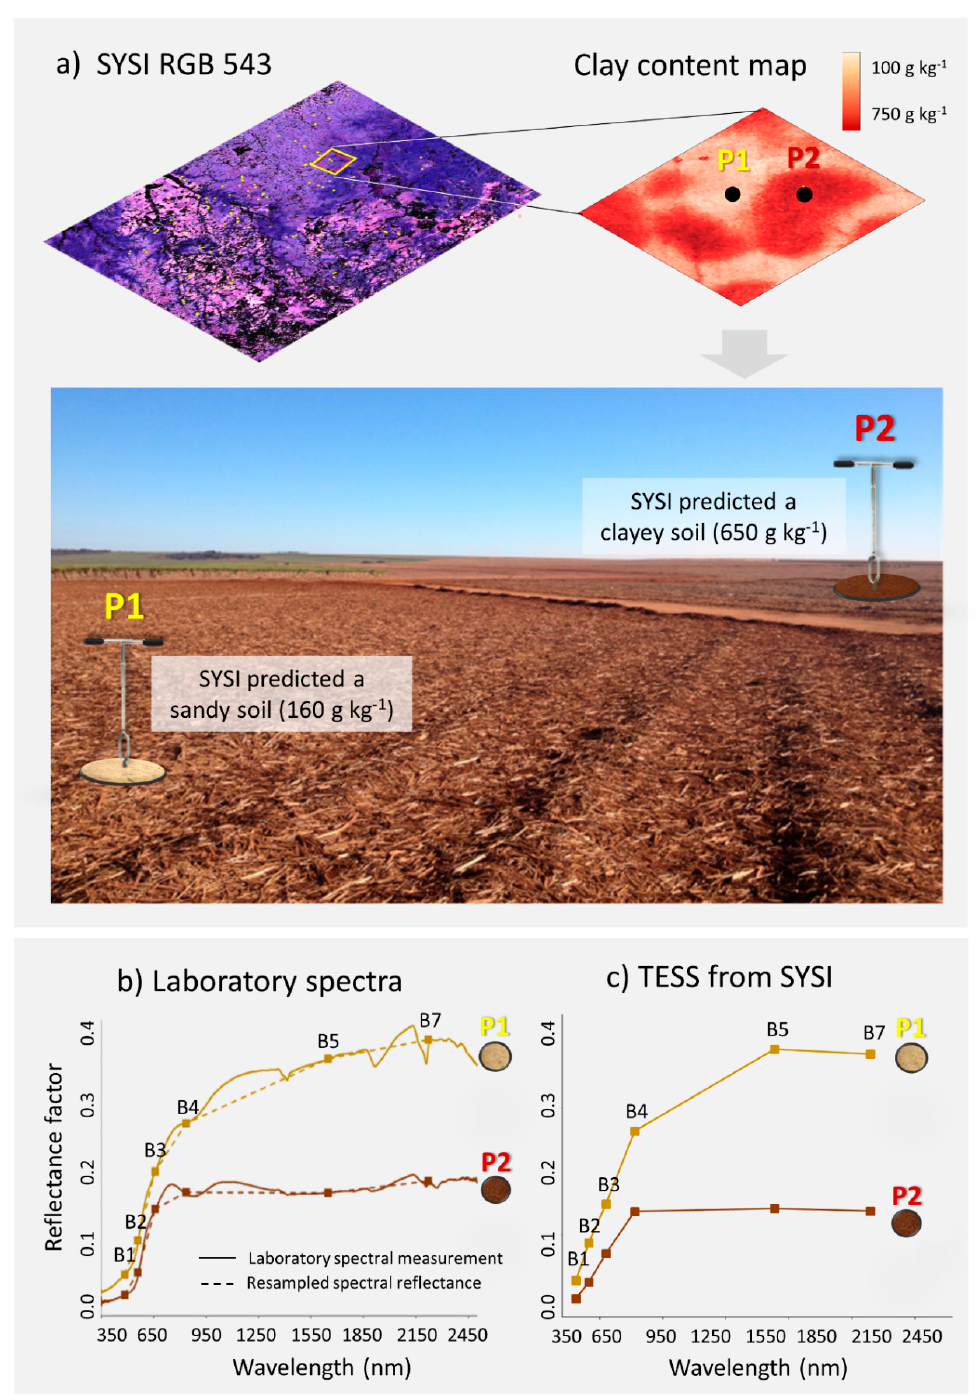
Figure 9. General illustration of the predicted clay map by Synthetic Soil Image (SYSI) for the same landform ( a ); resampled and laboratory spectral curves ( b ), and the Temporal Synthetic Spectral Reflectance (TESS) from the SYSI ( c ); B1 (450–520 nm), B2 (520–600 nm), B3 (630–690 nm), B4 (760–900 nm), B5 (1550–1750 nm), and B7 (2080–2350 nm).